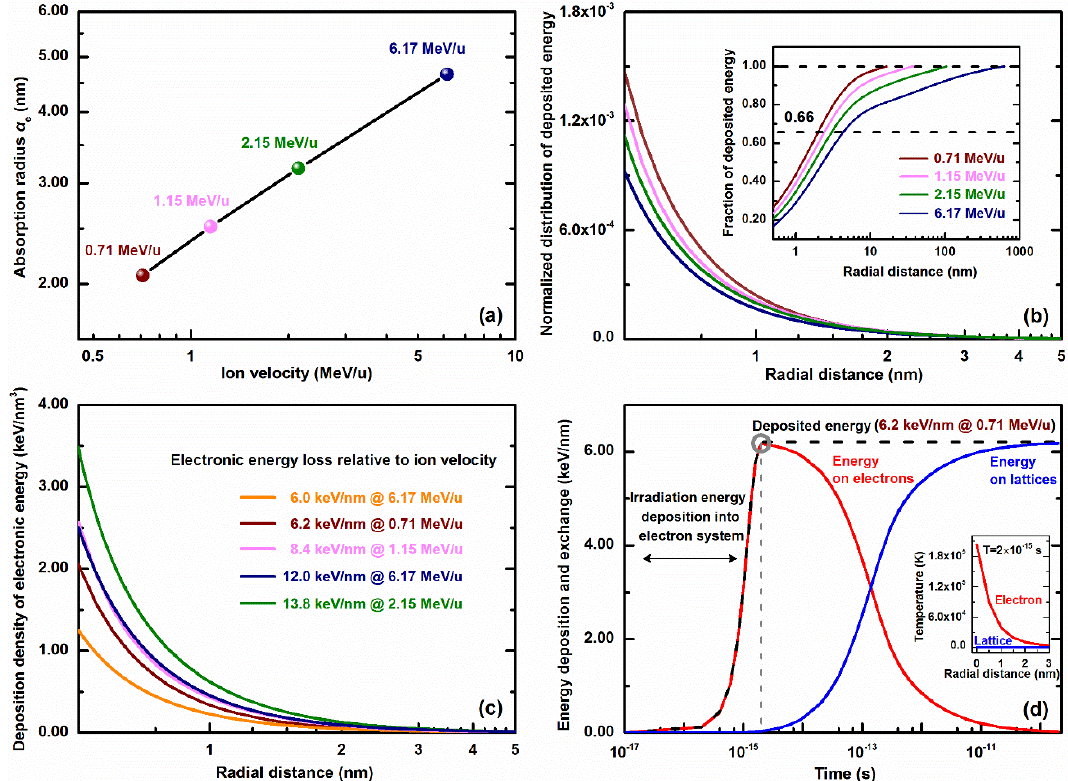
Figure 1. ( a ) Absorption radius α e of LiTaO 3 crystal for energy deposition via electronic energy loss as a function of ion velocity. ( b ) Normalized distribution of irradiation energy deposited to electron subsystem as a function of radial distance from ion trajectory. The fraction of energy deposited to the electron subsystem versus radius is also shown in the inset. ( c ) Density distribution of energy deposited to the electron subsystem via ion irradiation with different ion velocities and electronic energy losses. ( d ) Irradiation energy deposition and subsequent energy exchange processes between electron and lattice subsystems calculated by inelastic thermal spike model. The radial temperature distributions of the electron and lattice subsystems at 2 × 10 −15 s are also shown in the inset.